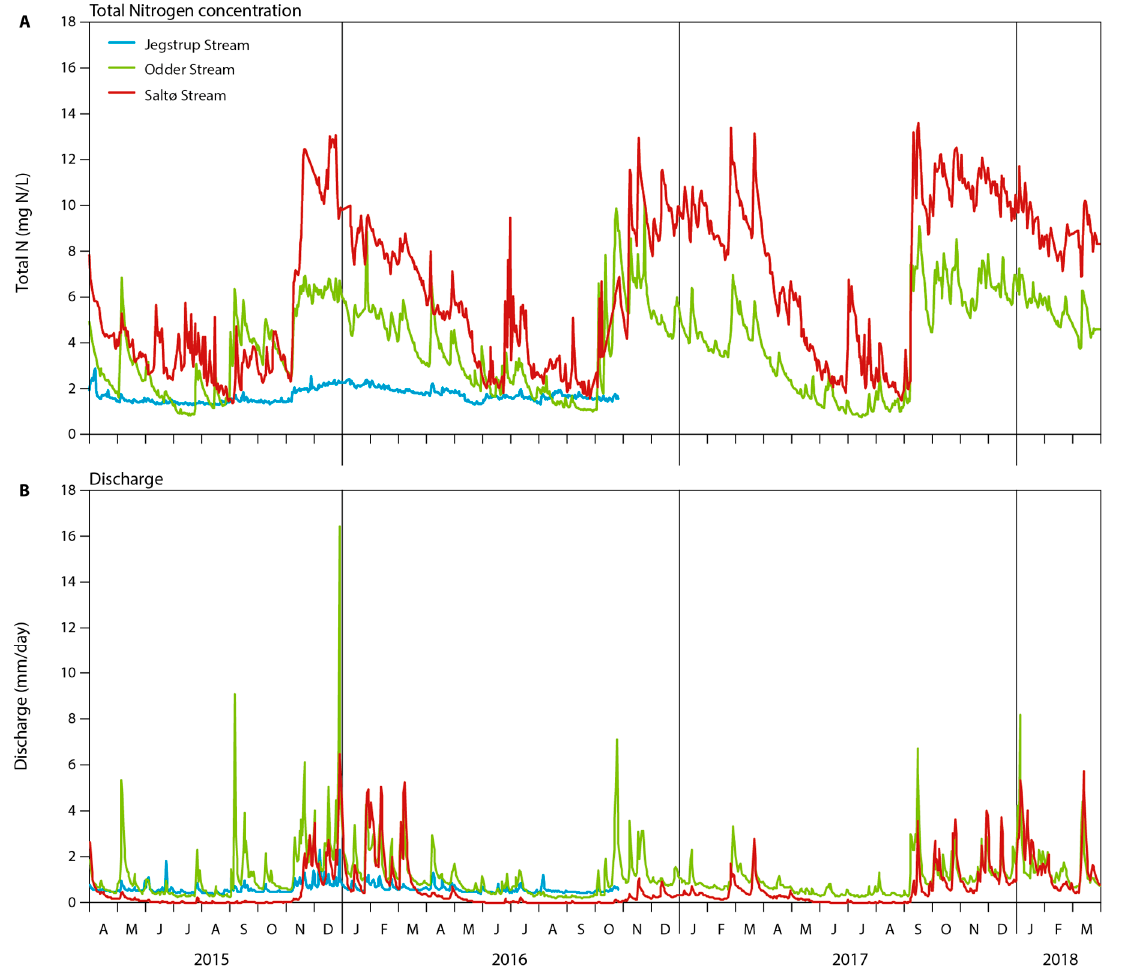
Figure 3. ( A ) Variations in TN concentration from 2015 to 2016 measured in the Jegstrup stream, Odder stream, and Saltø stream. ( B ) Variation in the measured discharge from 2015 to 2016 in the Jegstrup stream, Odder stream, and Saltø stream. Modified from [46].